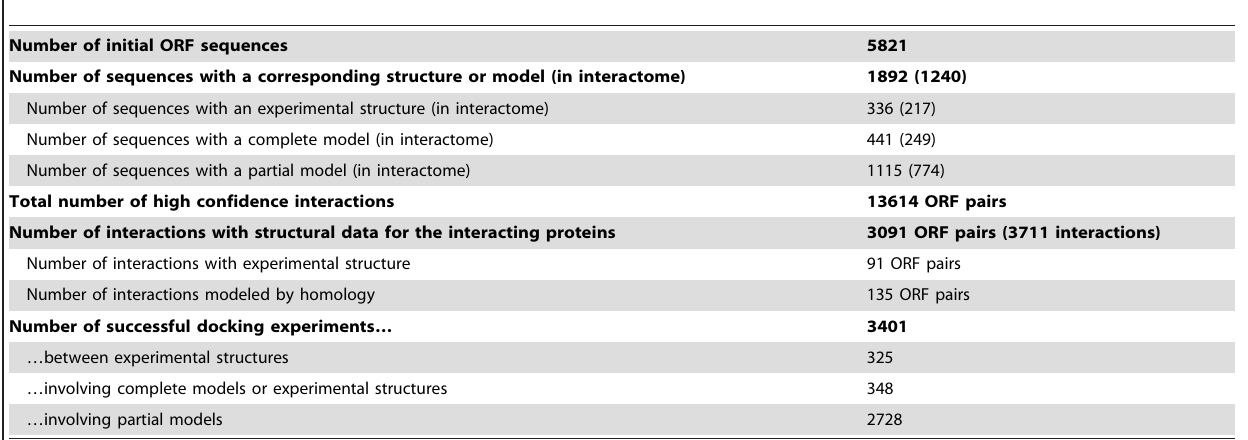
Table 1. Summary of the high-throughput docking